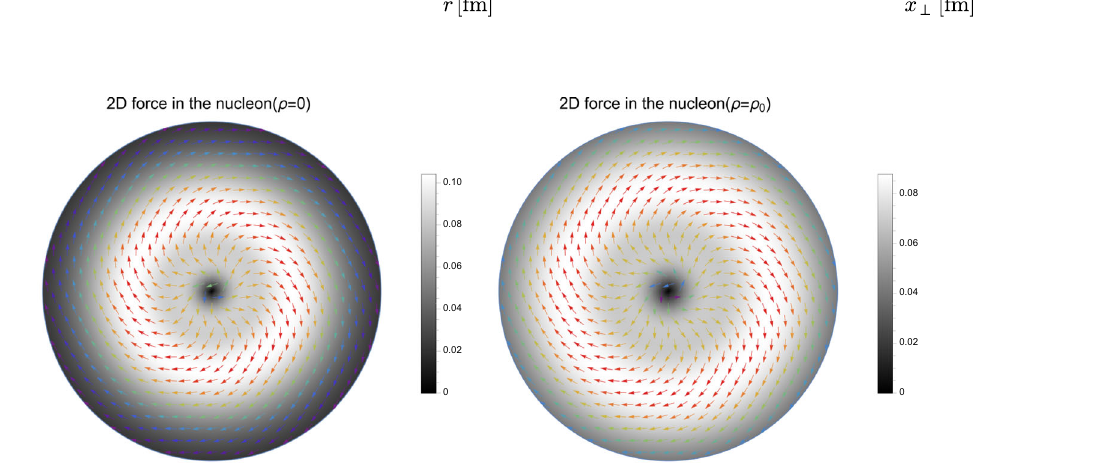
Fig. 11 3D and 2D tangential force fields inside the nucleon as functions of the nuclear density ρ . The short-dashed, long-dashed, and solid curves represent the tangential force fields with ρ = 0 , 0 . 5 ρ 0 ,ρ 0 , respectively. ρ 0 denotes the normal nuclear matter density